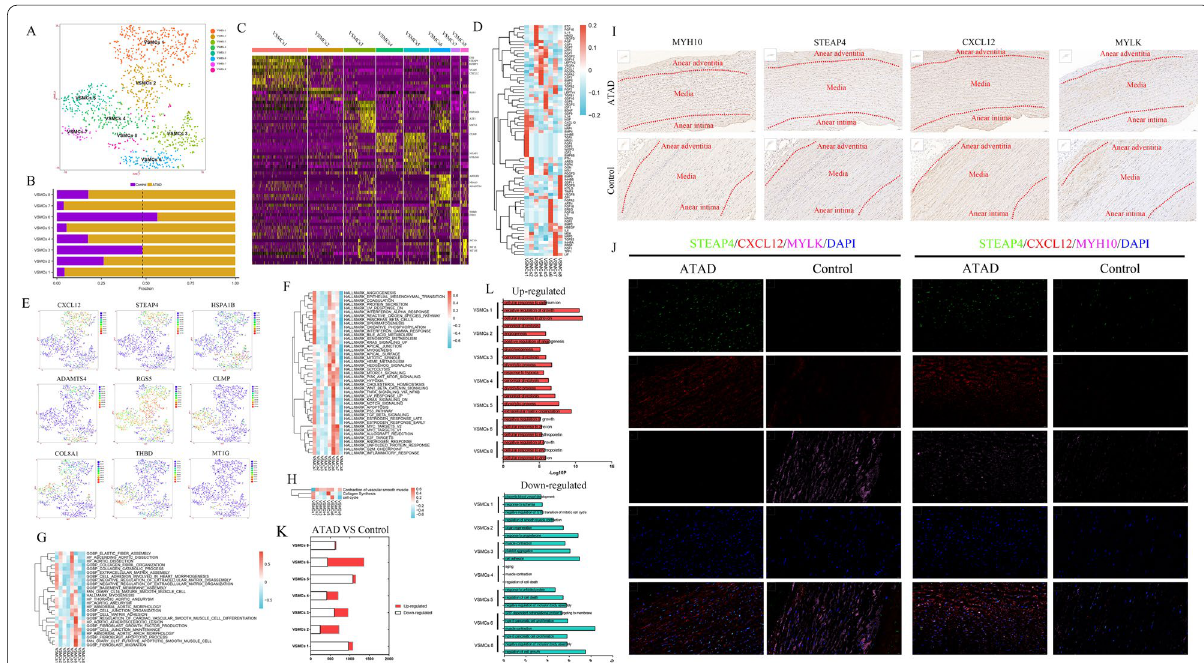
Fig. 1 Eight subpopulations of VSMCs were identified with different functions and markers including 2 new markers for synthetic VSMCs. A t‑SNE plot showed 8 subpopulations of VSMCs upon re‑clustering. B the proportion of each subpopulation of VSMCs between control and ATAD. The dashed line was used to discriminate the dominant subpopulations in ATAD and control group. C the heatmap of marker genes for each subpopulation of VSMCs. D the expression of growth factors in each subpopulation of VSMCs. E t‑SNE plots displayed the expression of representative marker genes for each subpopulation of VSMCs. F Qusage analysis of hallmark gene‑sets enrichment for each subpopulation of VSMCs. G Qusage analysis of selected gene‑sets enrichment relating to ATAD and functions of VSMCs for each subpopulation. H the results of Qusage analysis to identify functions of contraction, collagen synthesis and proliferation for each subpopulation of VSMCs. I IHC results showed higher expression of MYH10 (synthetic VSMCs markers), STEAP4 and CXCL12 in ATAD group, but the expression of MYLK (contractile VSMCs marker) was inverted. It also displayed similar expression characteristics of MYH10, STEAP4 and CXCL12 in same area except for MYLK. J IF revealed co‑expression of STEAP4/CXCL12/MYH10 but not STEAP4/CXCL12/MYLK (contractile VSMCs marker) in control and ATAD group, with higher positive proportion of STEAP4/CXCL12/MYH10 in ATAD group. K differential expressed genes (DEGs) in subpopulations of VSMCs (ATAD/Control). L GO analysis for up‑regulated and down‑regulated genes in subpopulations of VSMCs